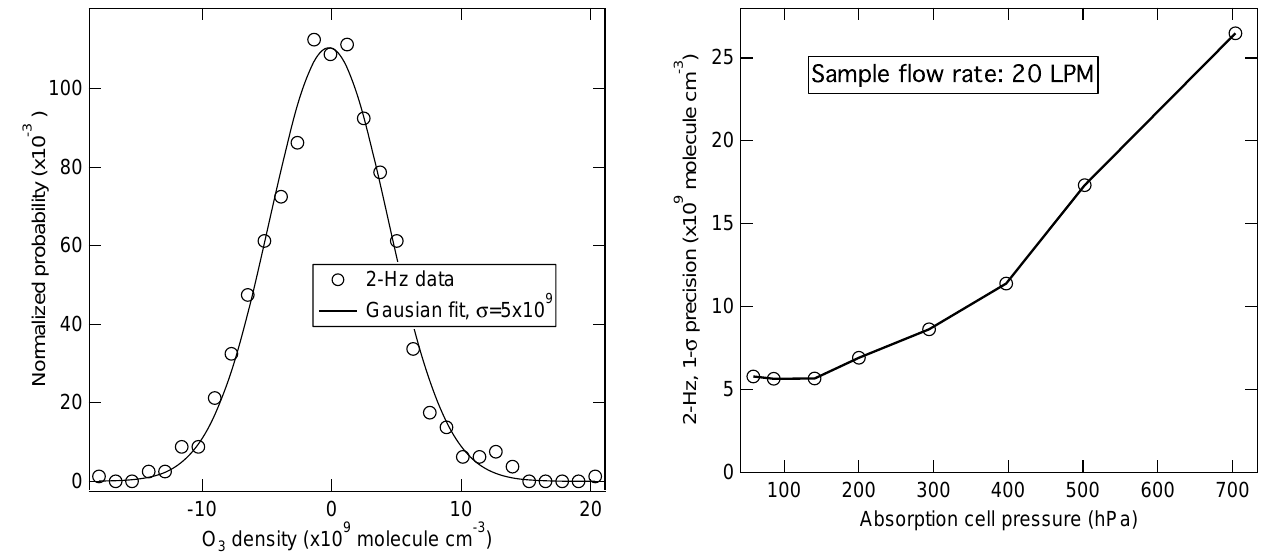
Fig. 5. A typical determination of the intrinsic instrument precision of NOAA-2 O 3 instrument. O 3 measurements recorded for a 1000-s period at 2Hz without sample flow were used to form a probability distribution function (PDF). The PDF integral is normalized to 1. As shown, the distribution of the data is very close to a perfect Gaus- sian, indicating that the measurement noise is random. The Gaus- sian fit gives a precision (2Hz, 1 σ ) of 5 × 10 9 molecule cm − 3 .